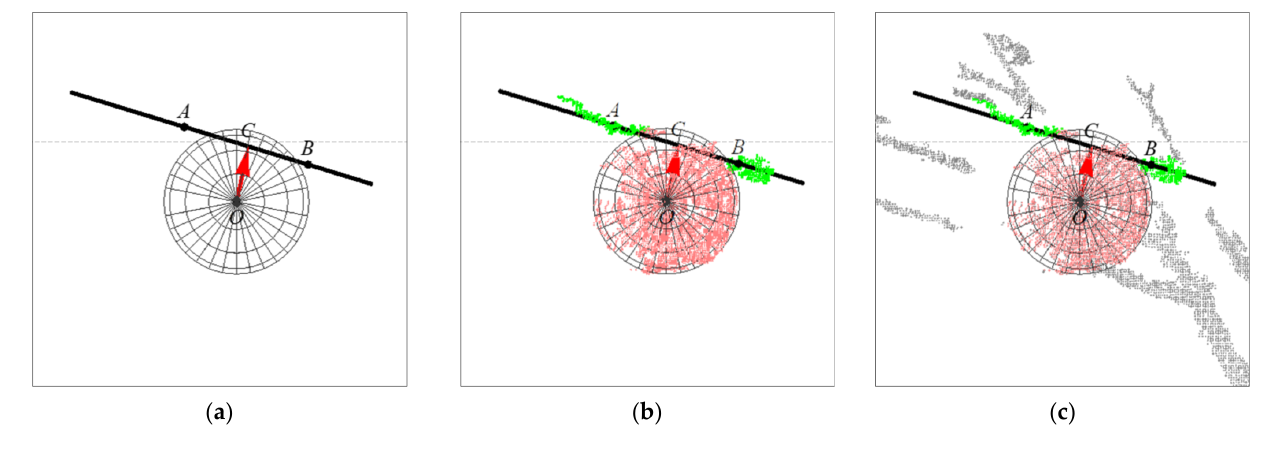
),,( zyxC , the desired vector OC can be obtained, and the calculation result is shown in Figure 10.